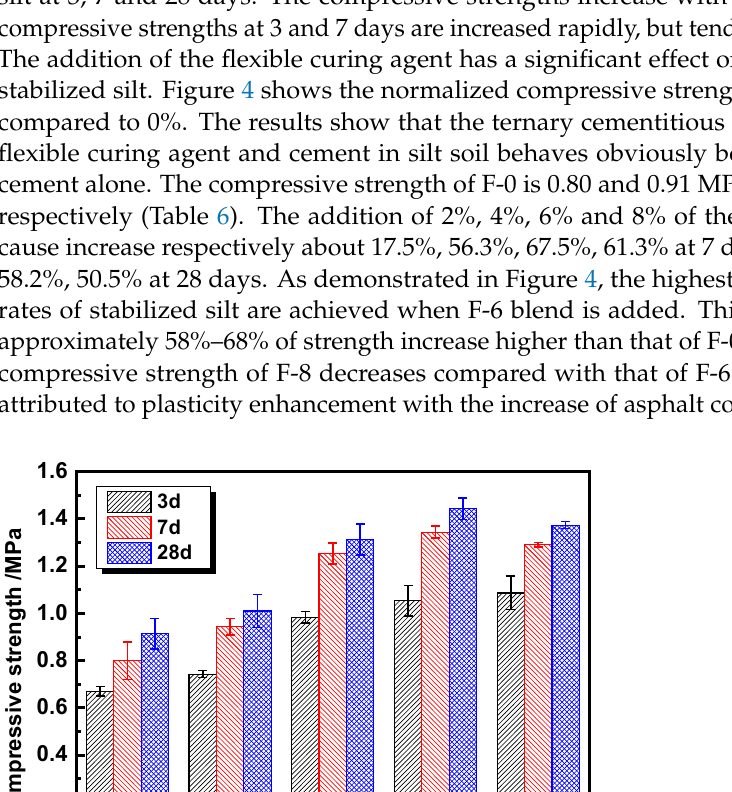
Figure 4. Normalized compressive strength of all stabilized soil related to F-0. Table 6. Standard and immersion compressive strength values of all specimens. Sample Compressive Strength/MPa 3 d 7 d